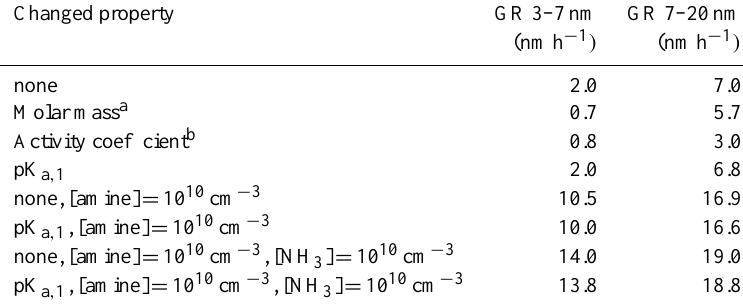
Table 4. Growth rates of particles calculated based on the dry size from the simulations where the properties of the organic acid were varied. First column indicates the property of organic acid which was changed from organic acid 1 to organic acid 2 (Table 1). First case (“none”) has all the properties of organic acid 1. Ammonia (10 9 cm − 3 ) and amine (10 9 cm − 3 ) concentrations were set to base case values, unless otherwise stated. Organic acid concentration and saturation vapour pressure were 3 × 10 8 cm − 3 and 10 − 6 Pa. Sulfuric acid concentration (10 6 cm − 3 ) , RH (40%) and temperature (283.15K) were set to base case values in all simulations (Table 2).